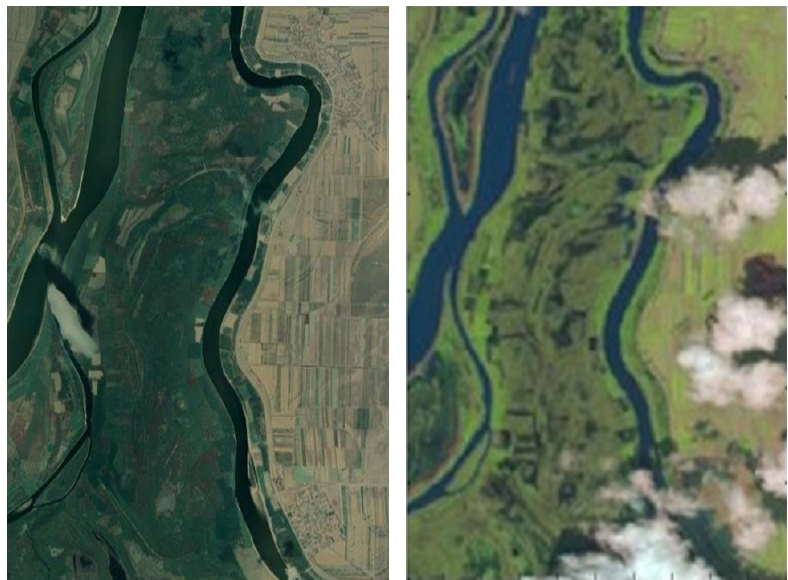
Figure 7. The true color of the Br˘aila dataset (an area of Br˘aila’s Small Island; a satellite view available from Google Maps, ( left [39]), and the true color provided by the EO-1–Hyperion satellite together with the hyperspectral image ( right [41]; see Figure